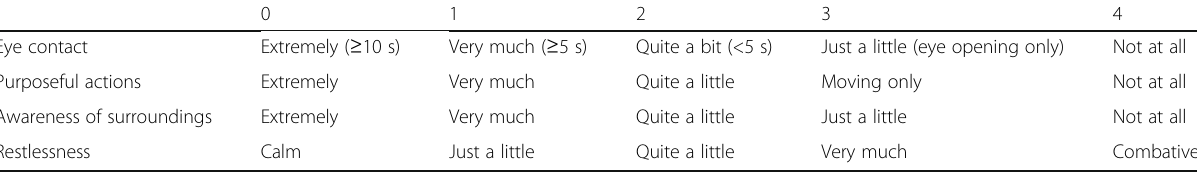
Table 1 Modified pediatric anesthesia emergence delirium